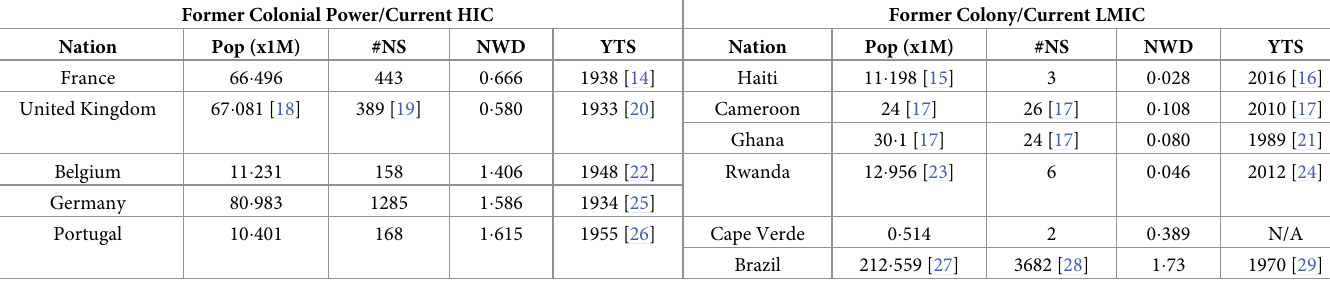
Table 1. Comparison of current neurosurgical